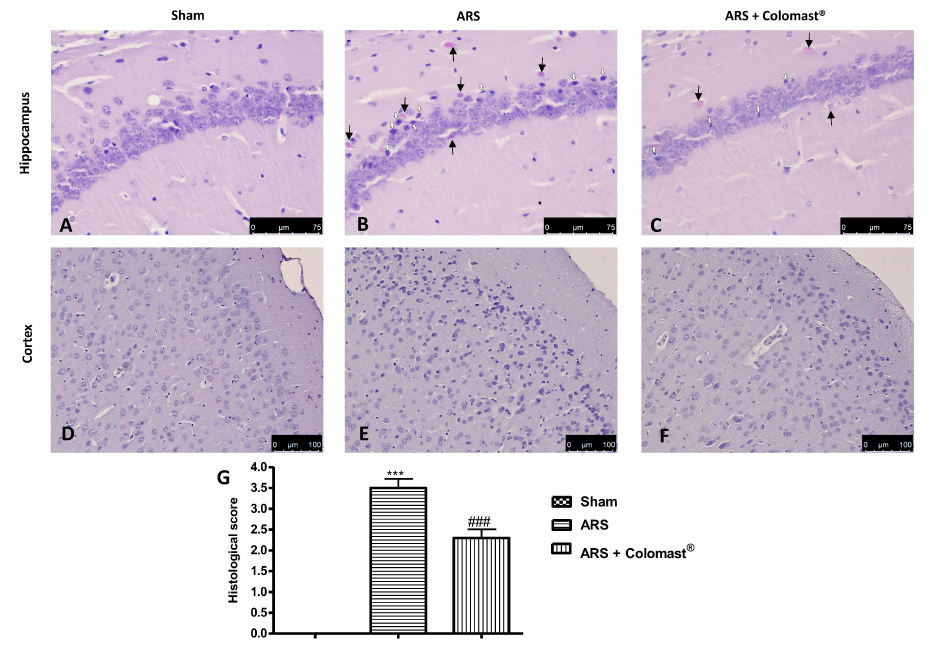
Figure 10. Effect of Colomast ® pre-treatment on brain tissue damage. Histological evaluation of hippocampus in sham ( A ), ARS ( B ), Colomast ® ( C ), and cortex in sham ( D ); ARS ( E ); Colomast ® ( F ); Histological score ( G ). The black and white arrow indicated injured neurons (cell with pyknotic nuclei or acidophilic cytoplasm). Images are figurative of at least three independent experiments. Values shown are means ± SEM of six animals in each group. For the histology, a 40× magnification is shown (75-µm scale bar) for hippocampus, a 20× magnification is shown (100-µm scale bar) for cortex. *** p < 0.001 vs. sham; ### p < 0.001 vs. ARS group.